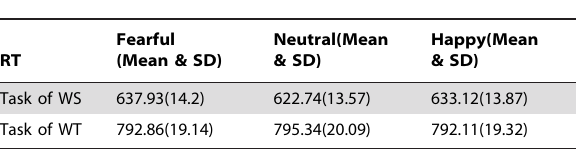
Table 1. Means and standard deviations of the reaction time (ms) for the word structure (WS) and word tone judgment tasks (WT) when fearful, neutral and happy faces were unattended